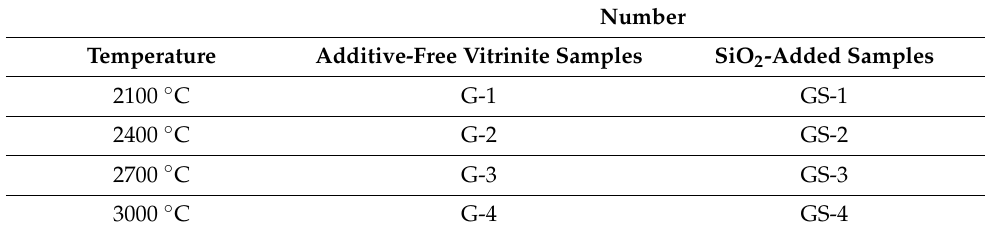
Table 2. High-temperature simulation experimental